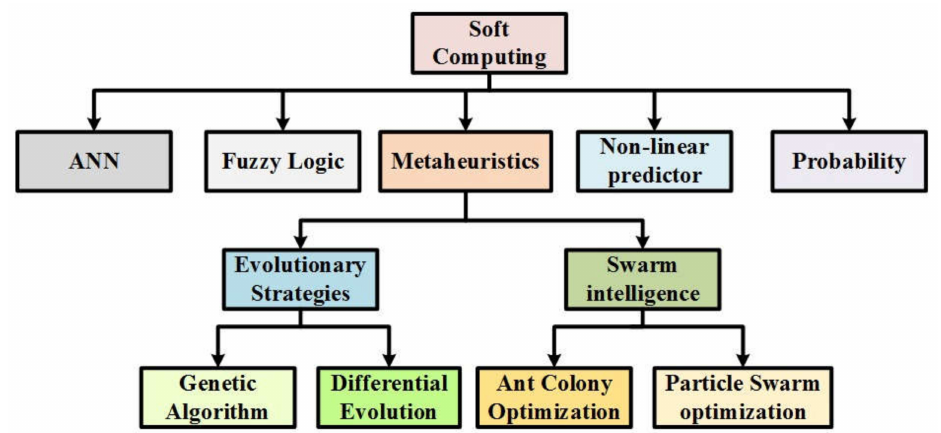
Figure 6. Soft Computing